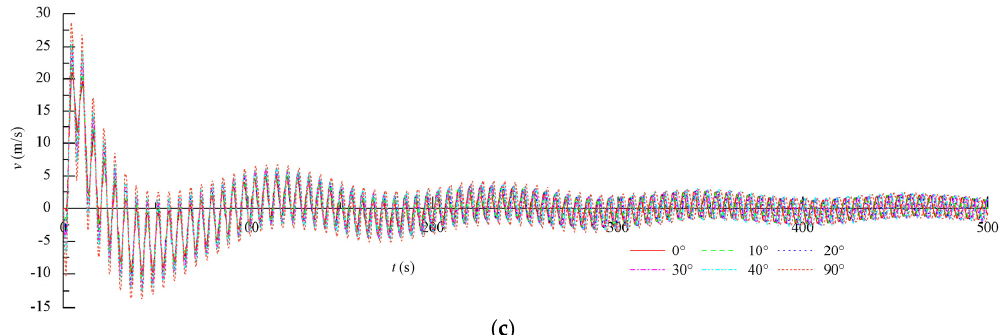
Figure 13. Effect of the ventilation tunnel dip angles on wind speed. ( a ) Positive and negative (extrema) envelope curves along the ventilation tunnel axis; ( b ) wind speed fluctuation processes in the first section; ( c ) wind speed fluctuation processes in the last section.